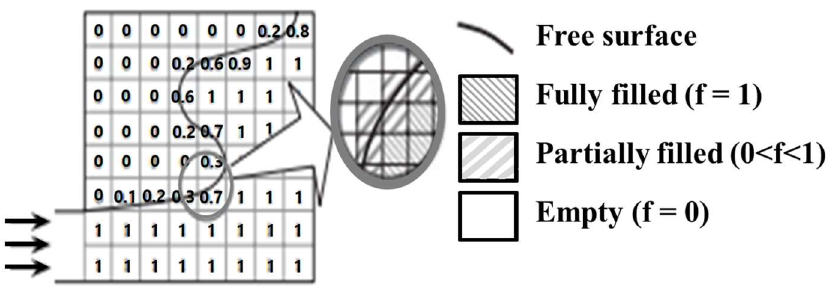
Figure 4. Determination of fluid flow with a moving free surface by using the volume of fluid (VOF) method [24–26].